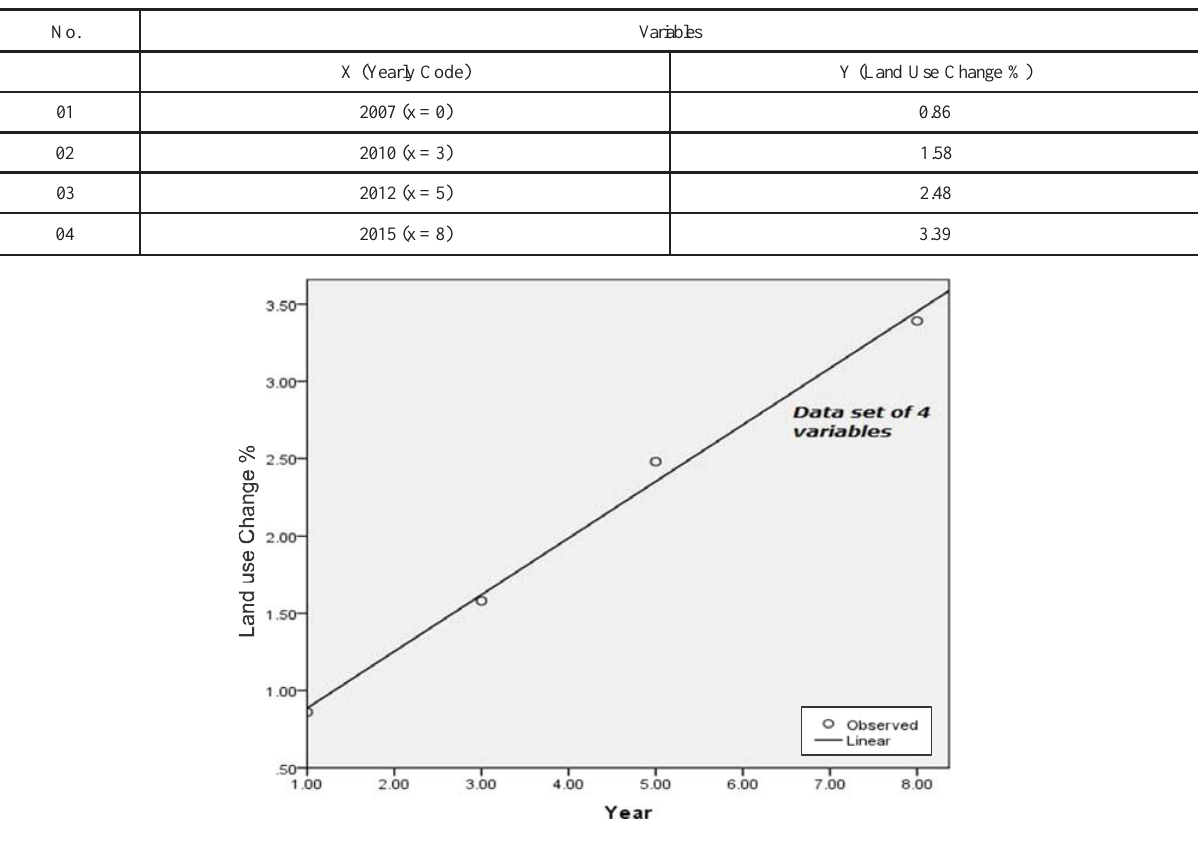
TABLE 1. YEARLY CODE AND LAND USE CHANGE PARAMETERS FOR LINEAR REGRESSION